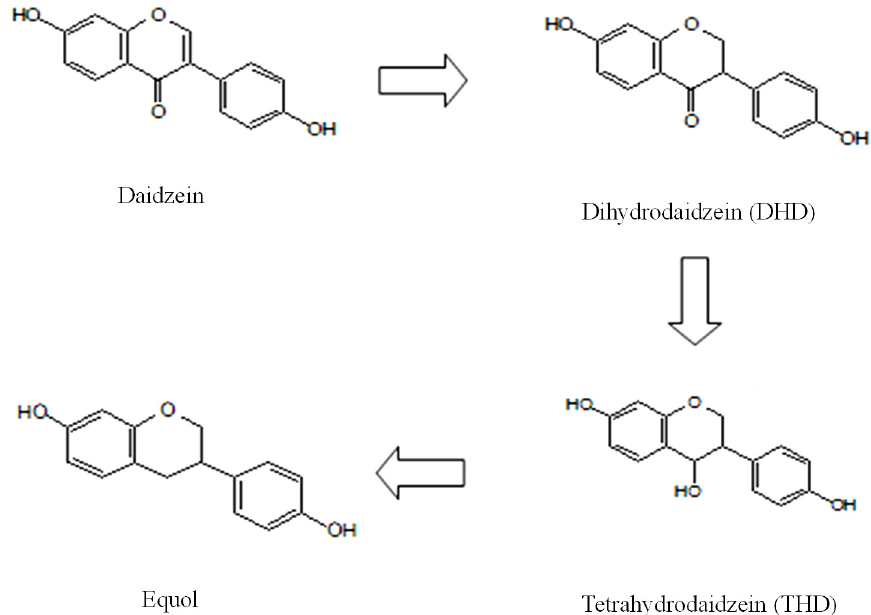
Figure 4. Proposed pathway for daidzein reduction by intestinal microbiota